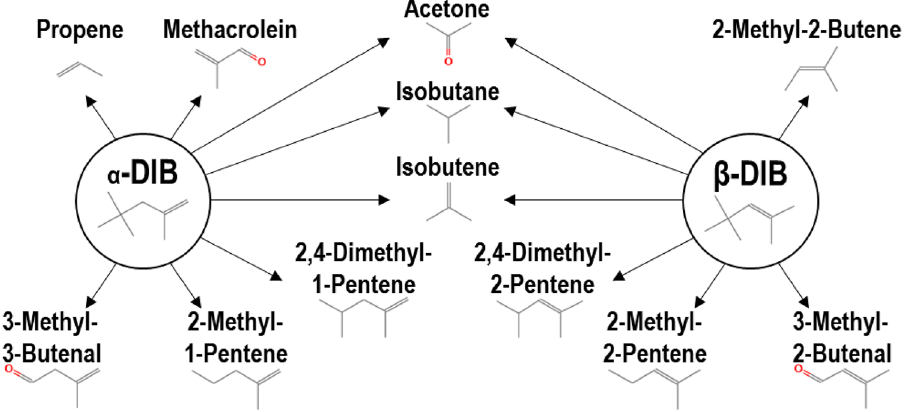
Figure 7. Identified byproducts from initiating reactions of α- and β-DIB.